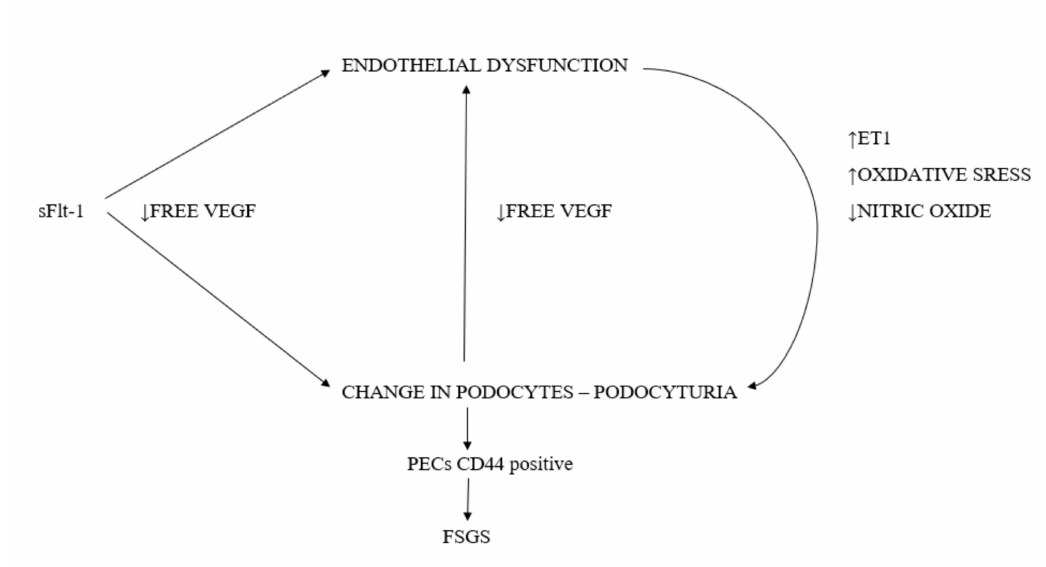
Figure 2. The scheme of podocytes injury in